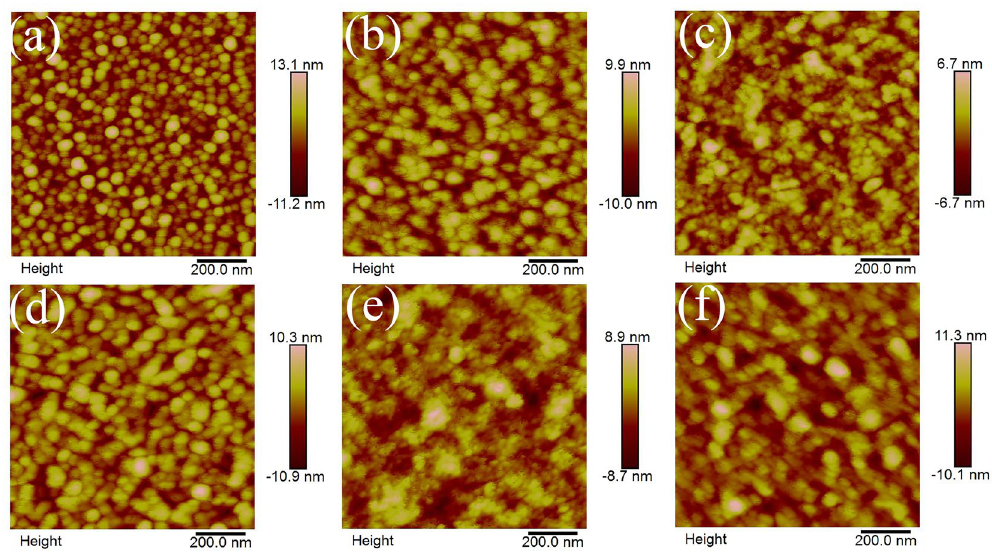
Figure 2. AFM images of VO 2 films of nominal 1%, 1.5% and 2% W doped samples. ( a ~ c ) annealed at 470 °C/4 h; ( d ~ f ) annealed at 500 °C/4